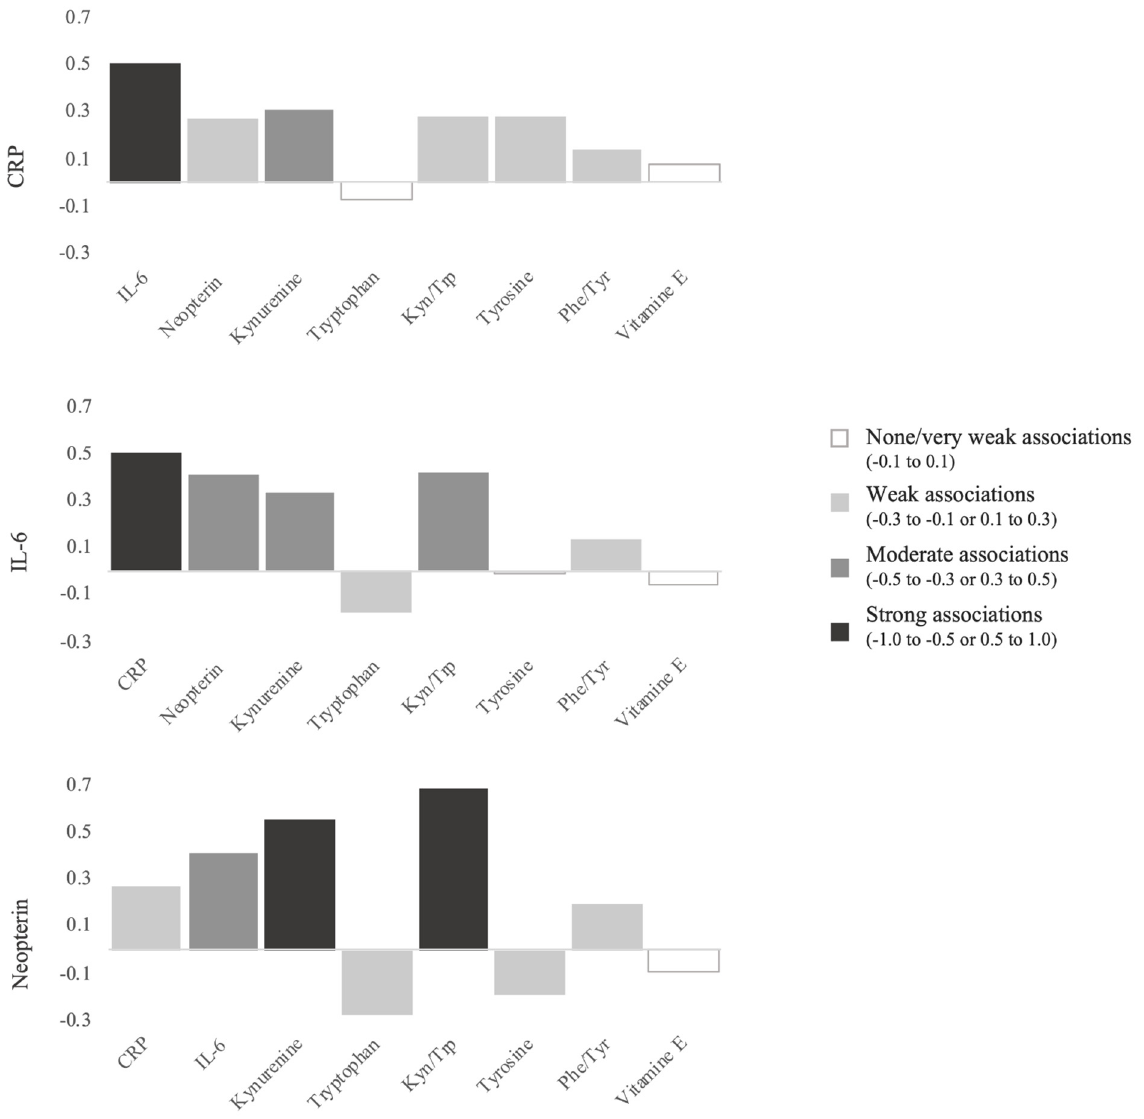
Figure 4. Correlation coefficients between analysed biomarkers.